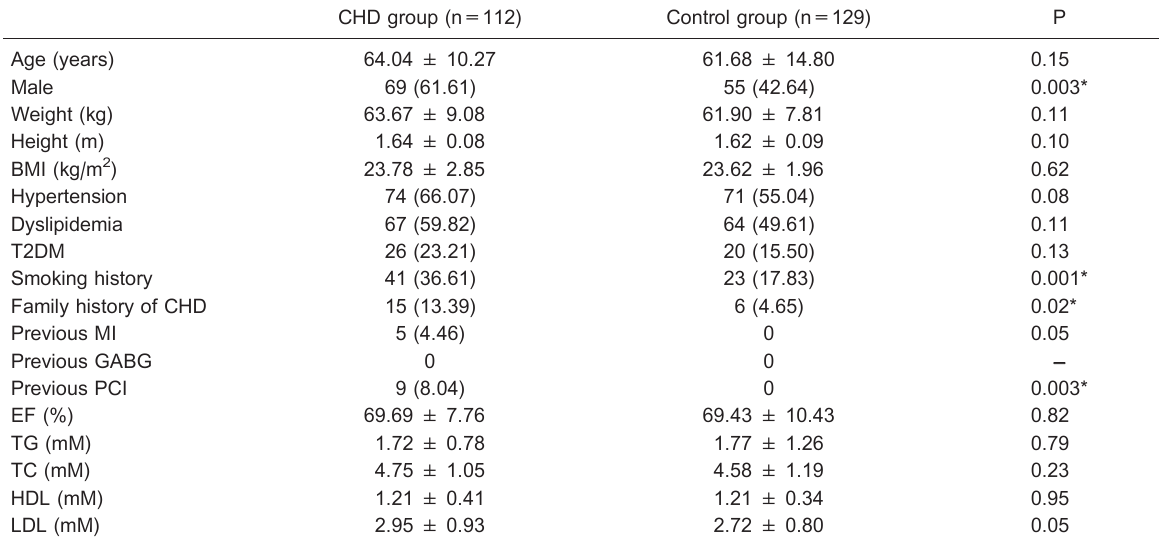
Table 3. Baseline clinical and examination data of the two